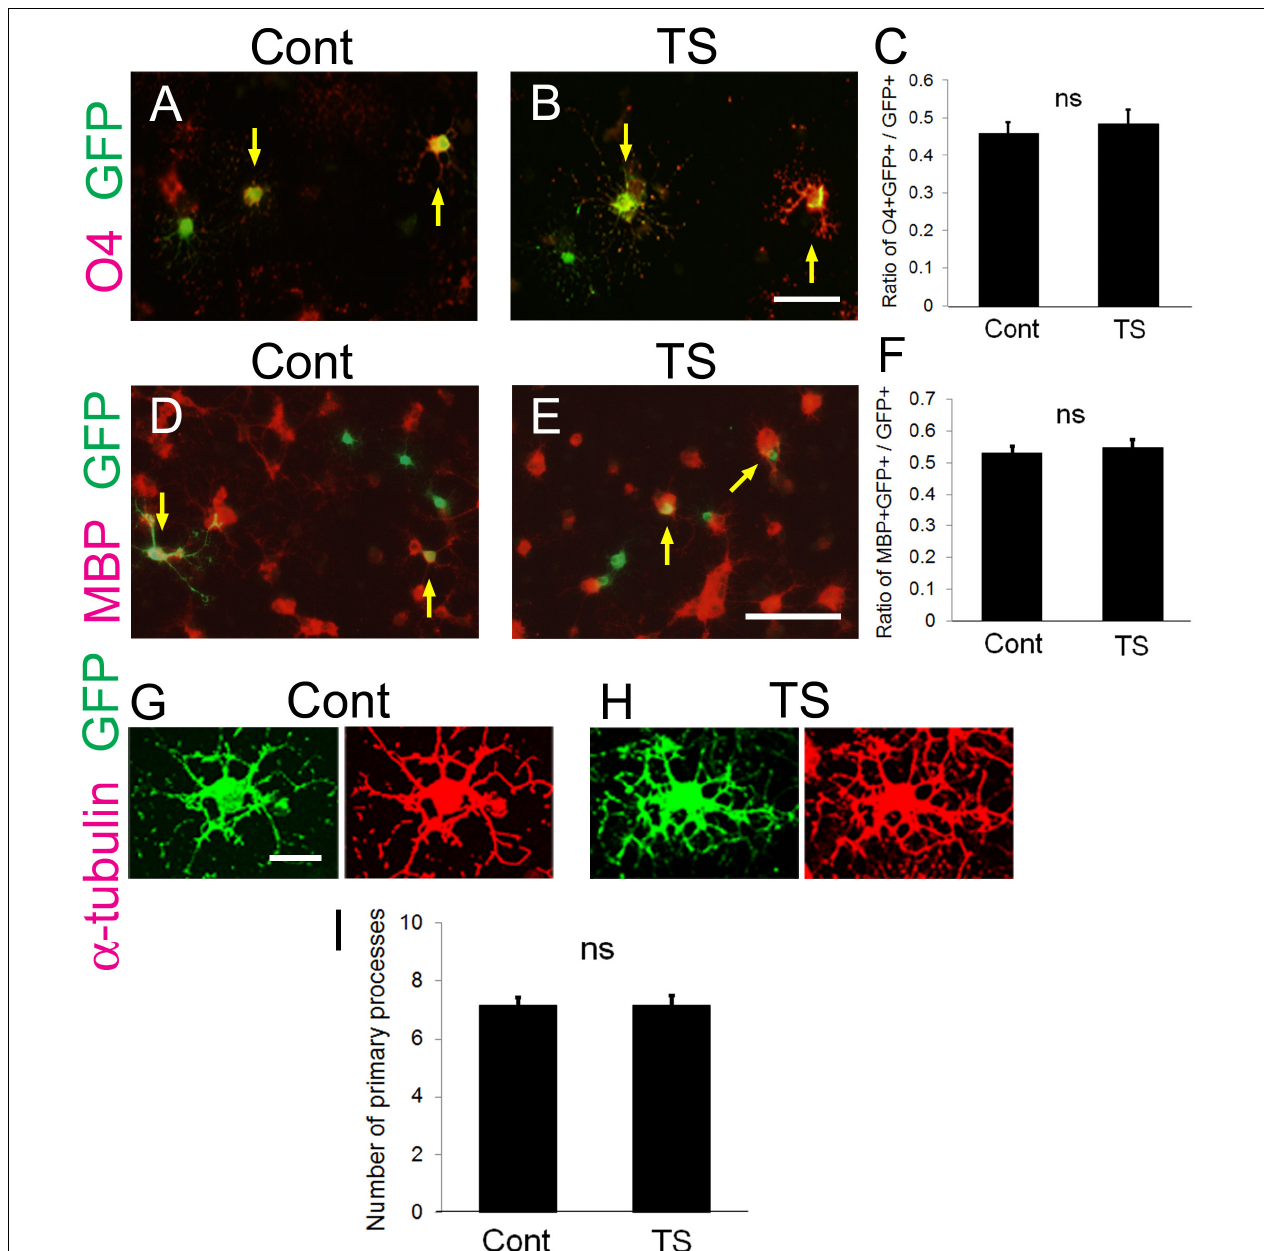
FIGURE 2 | Transfection of the tension sensor does not affect OL differentiation and morphogenesis. (A–C) The number of O4 + immature and mature OLs [red in (A,B) ] among the GFP + tension sensor (TS) -expressing cells (B) was comparable to that in GFP-expressing control cells (A) on laminin-coated dishes. The transfected cells were detected by GFP expression (green). PDGF-AA and bFGF were removed from the culture medium 1 day after transfection, and triiodothyronine (T3, 30 ng/ml) was applied. Cells were maintained for 2 additional days, and then fixed for immunostaining with anti-O4 antibody. Arrows indicate O4-GFP double-positive cells. Scale bar, 50 µ m. (C) The ratio of O4 + GFP + cells/GFP + cells was quantified (ns, no significant difference compared with control values, Student’s t -test; n = 25 fields of view analyzed per condition, from three independently prepared cultures established on different days). (D–F) The number of MBP + mature OLs [red in (D,E) ] among the GFP + tension sensor (TS)-expressing cells (E) was comparable to that in GFP-expressing control cells (D) on laminin-coated dishes. The transfected cells were detected by GFP expression (green). Cells were maintained for 5 days in the differentiation medium. Arrows indicate MBP-GFP double-positive cells. Scale bar, 100 µ m. (F) The ratio of MBP + GFP + cells/GFP + cells was quantified (ns, no significant difference compared with control values, Student’s t -test; n = 21 fields of view analyzed per condition, from four independently prepared cultures established on different days). (G–I) Transfection of the tension sensor did not affect the number of OL primary processes on laminin-coated dishes. Cells were maintained for 3 days after removal of PDGF-AA and bFGF from the culture medium. OL processes were visualized by immunostaining with an anti- α -tubulin antibody (red). Scale bar, 20 µ m. (I) The number of primary processes per GFP + OL was quantified (ns, no significant difference compared with control values; Student’s t -test, n = 27 cells analyzed per condition, from three independently prepared cultures established on different days).